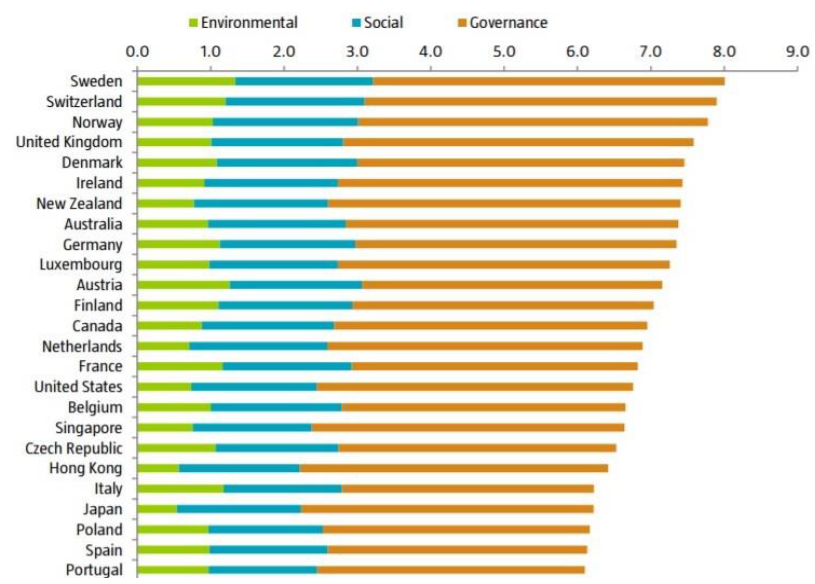
Fig. 1. World Sustainability Ranking, April 2016 (RobecoSam,